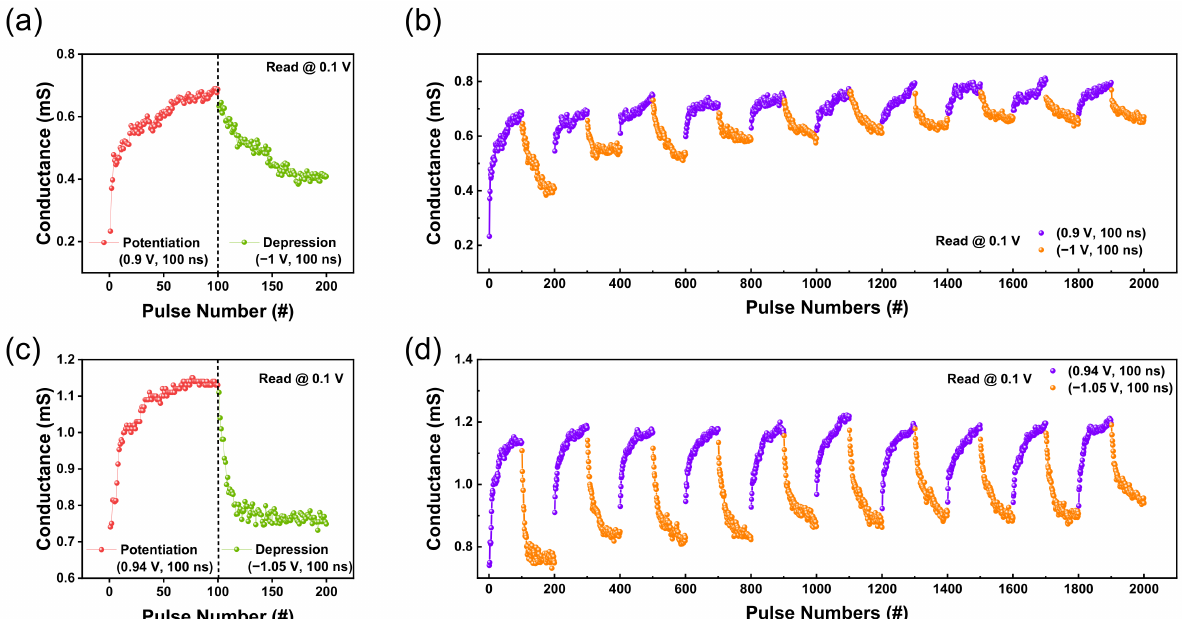
Figure 5. Ta/TaO x /Pt device: ( a ) LTP and LTD are established with 100 identical write pulses (amplitudes of 0.9 V, the pulse width of 100 ns) and erase pulses (amplitudes of − 1 V, the pulse width of 100 ns) ( b ) Ten cycles of potentiation and depression (potentiation first). Ta/TaO x :N/Pt device: ( c ) LTP and LTD are established with 100 identical write pulses (amplitudes of 0.94 V, the pulse width of 100 ns) and erase pulses (amplitudes of − 1.05 V, the pulse width of 100 ns) ( d ) Ten cycles of potentiation and depression (potentiation